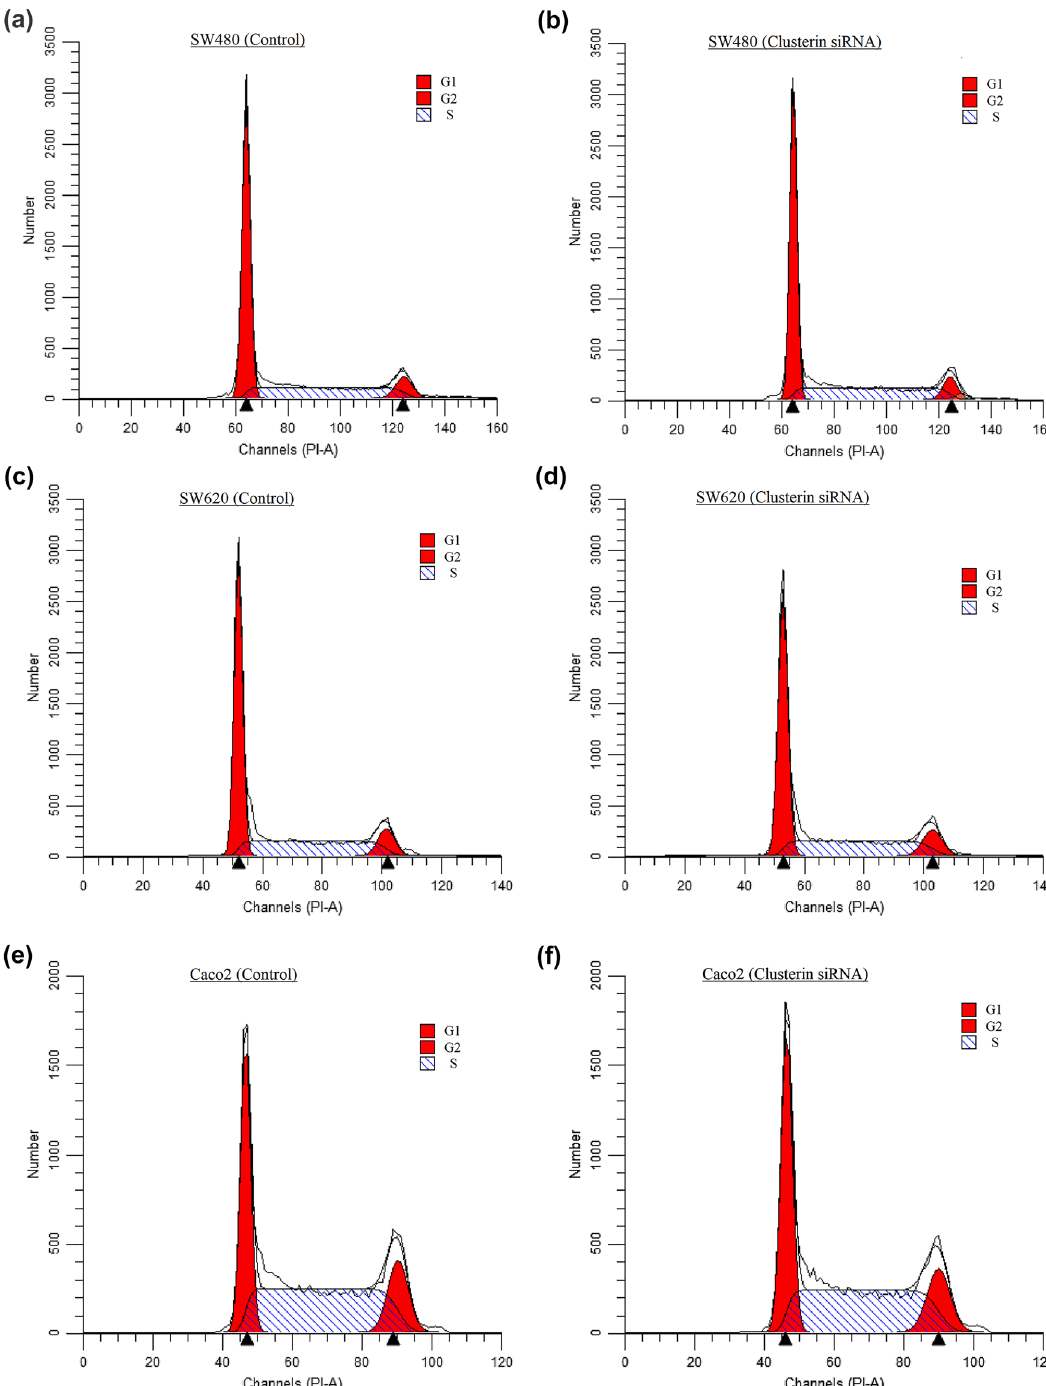
Figure 3: Cell cycle arrest in clusterin-silenced SW480, SW620, and Caco2 for 72 h. Non-silenced colorectal cancer cells were used as the control compared to clusterin-silenced cells (clusterin